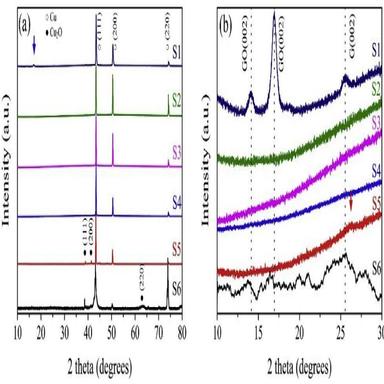
(a) XRD patterns for S1eS6 with mainly a Cu-fcc phase (PDF 00-004-0836). (b) Close up inspection in the 10e30 range revealed the presence of three peaks in S1, these signals correspond to the (002) crystallographic plane, typical of graphitic material (25.8), the (002) crystallographic plane attributed to graphite oxide (14.1) and graphite poorly oxidized (16.8). (A colour version of this figure can be viewed online.)